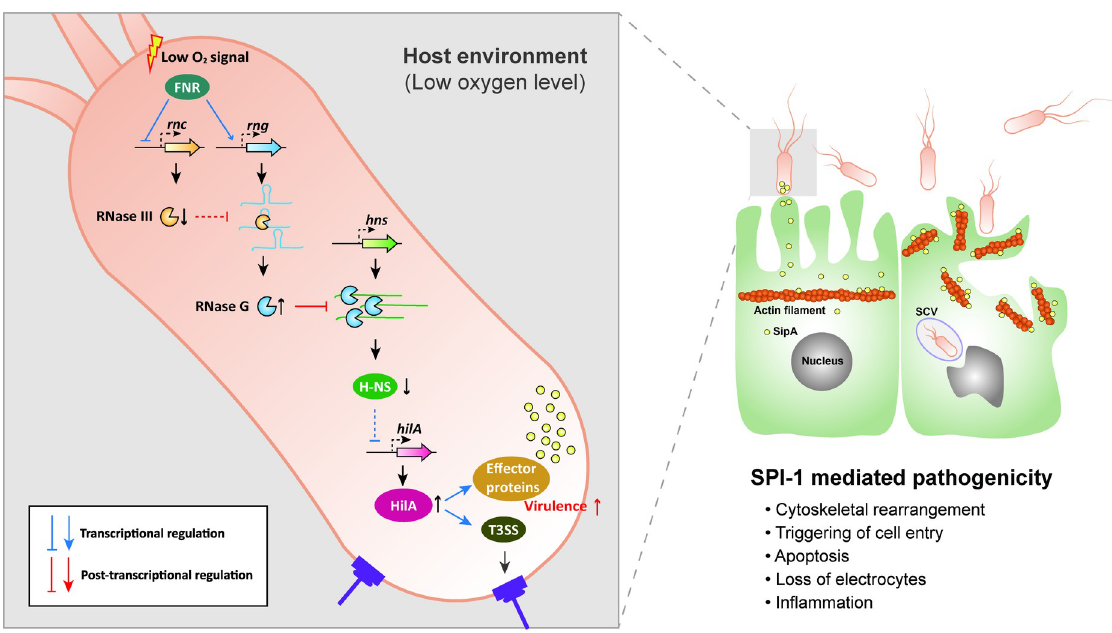
Fig 7. Model for the adaptive pathogenicity of S . Typhimurium to the host environment via the sequential modulation of RNase III and RNase G endoribonucleolytic activity. Host environmental signals triggered by the exposure of S . Typhimurium to low oxygen (anaerobic) conditions activate the regulation of the oxygen sensing regulator, FNR. FNR reduces RNase III levels by inhibiting rnc gene expression and promotes rng mRNA by activating rng gene expression, leading to increased cellular RNase G levels. RNase G induction accelerates the degradation of the hns mRNA 5 0 UTR, thus downregulating hns mRNA levels. H-NS usually represses hilA gene expression; however, decreased cellular H-NS levels appear to activate the hilA promoter. HilA activates SPI-1 T3SS genes and induces the encoded effector proteins. These virulence cascades increase the invasiveness of S . Typhimurium to result in pathogenic S . Typhimurium